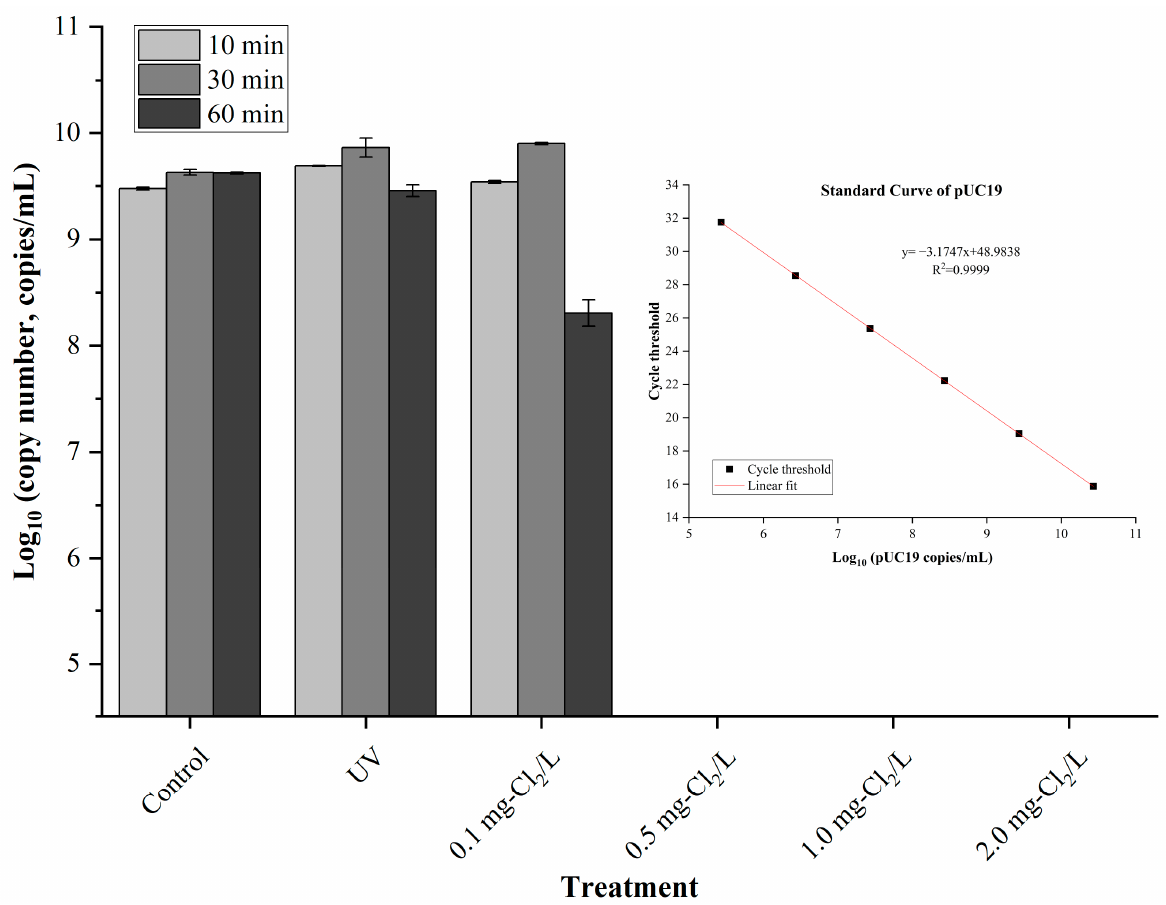
Figure 3. Copy numbers of pUC19 after different treatments as determined using qPCR.